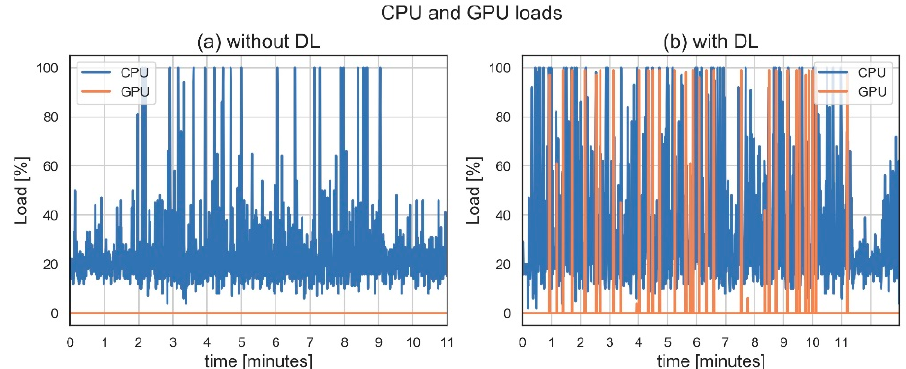
Figure 6. CPU and GPU loads on the edge device without ( a ) and with ( b ) the deep learning (DL) suite.